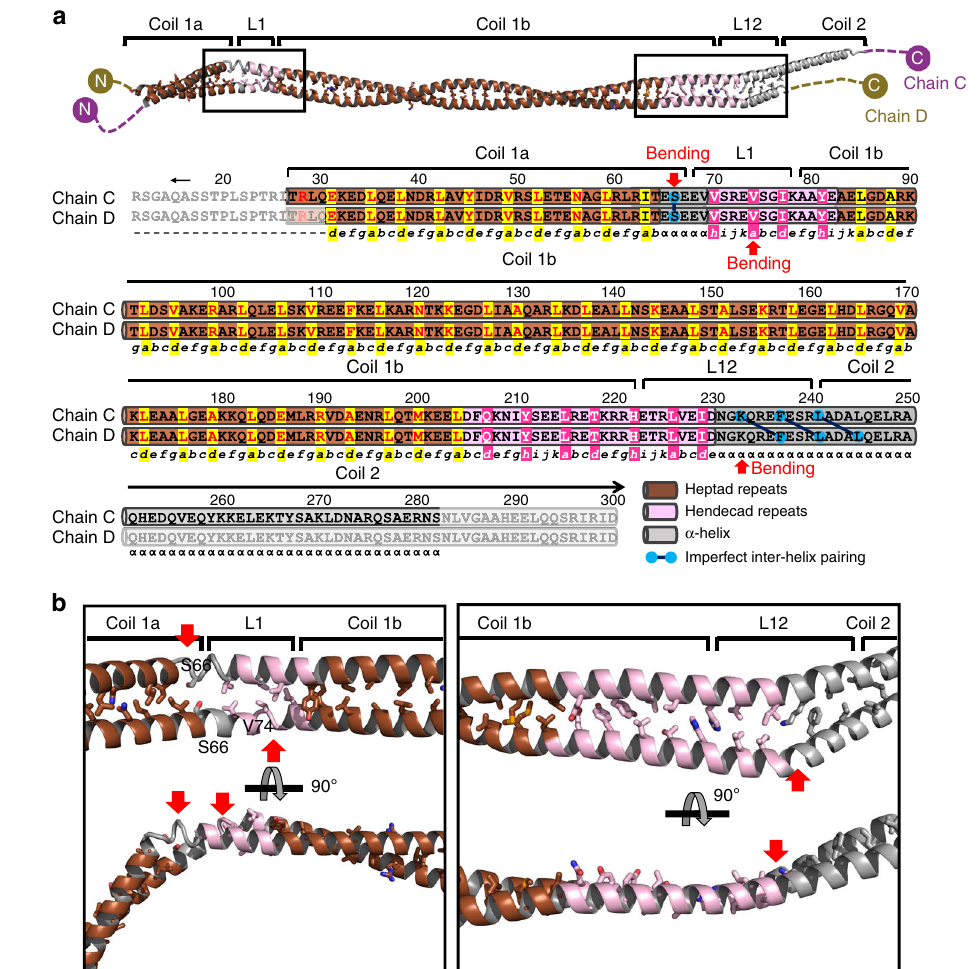
Fig. 2 Structural-based superhelicity and sequence periodicity of the lamin C:D dimer. a Structure-based analysis of the sequence periodicity of the heptad (shaded in brown or yellow) or hendecad (shaded in pink or magenta) repeats. The phases of the heptad (abcdefg) and hendecad (abcdefghijk) repeats are described below the sequences. The hydrophobic residues (a, d, and h) involved in the inter-helical interaction are highlighted by shadowing. If no inter- helical interaction occurs, α is used instead. Bends in the α -helices are indicated by red arrows. The mismatched interaction between two α -helices is highlighted with linked blue circles. The disordered regions are masked with semi-transparent boxes. The analyses of the A:B dimer are provided in Supplementary Fig. 1b. b Inter-helical hydrophobic interactions of the linkers L1 and L12 proximal regions in the C:D dimer. Heptad repeat periodicity exhibiting the left-handed coiled-coil structure is coloured brown, whereas the hendecad repeat periodicity in the untwisted α -helical dimer is coloured pink. Grey α -helices indicate an unmatched hydrophobic interaction between two α -helices in the dimer. Hydrophobic residues associated with inter-helical interactions in the L1 and L12 proximal regions are shown in stick representations in the orthogonal views. The bending in the α -helices is indicated by red